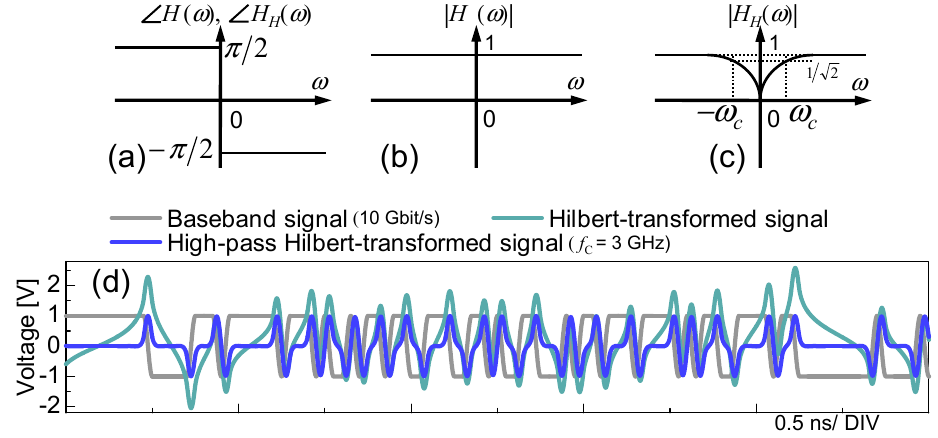
Figure 10. ( a ) phase response of H ( ω ) and H H ( ω ), ( b ) amplitude response of Hilbert transform H H ( ω ), ( c ) amplitude response of high-pass Hilbert transform H H ( ω ), ( d ) 10 Gbit/s NRZ-coded baseband signal and its Hilbert-transformed waveforms ( f c = 3 GHz of H H ( ω )).